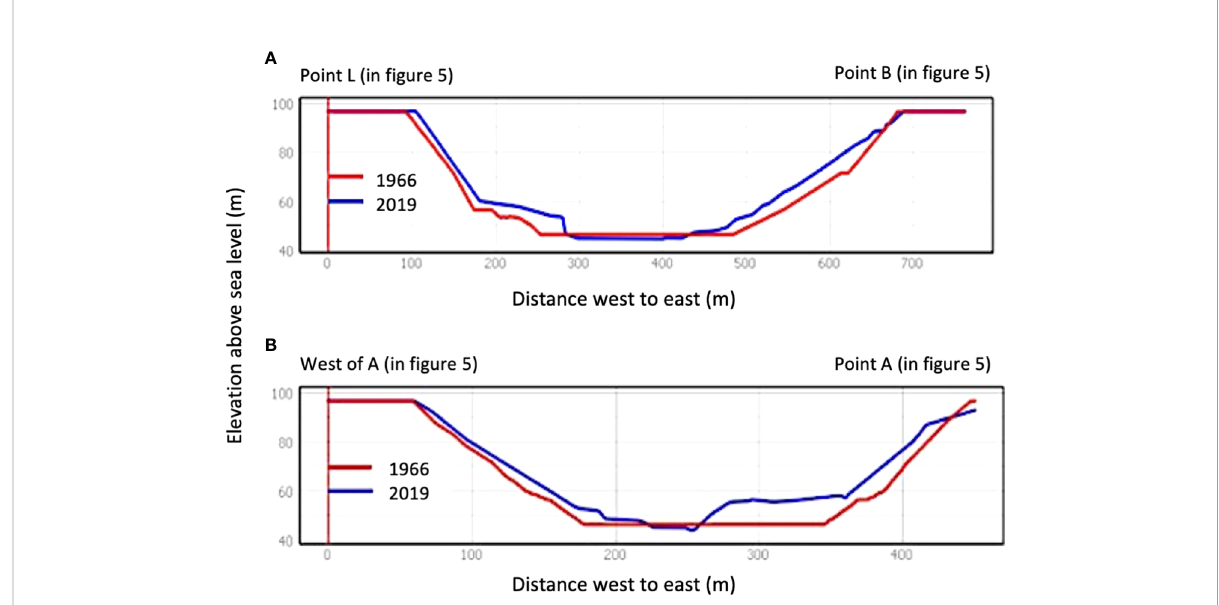
FIGURE 6 Cross sections of the reservoir lake of La Concepcio ́ n. Labels are referred to Figure 5 locations. (A) Cross section from the east shore of spot elevation B to the west of spot elevation L. (B) From east of point A to directly